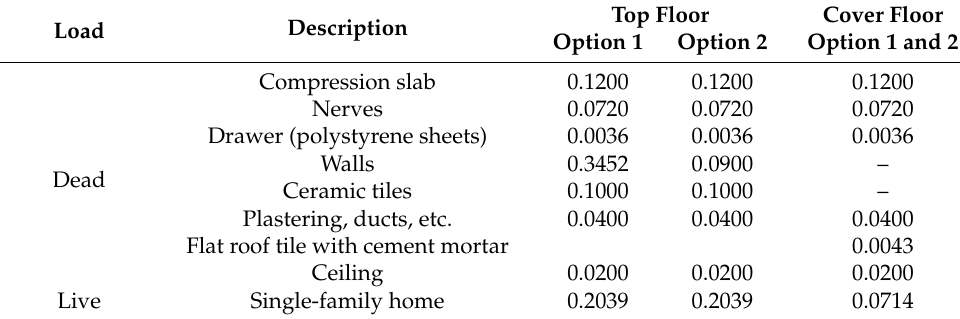
Table 2. Loads applied to the